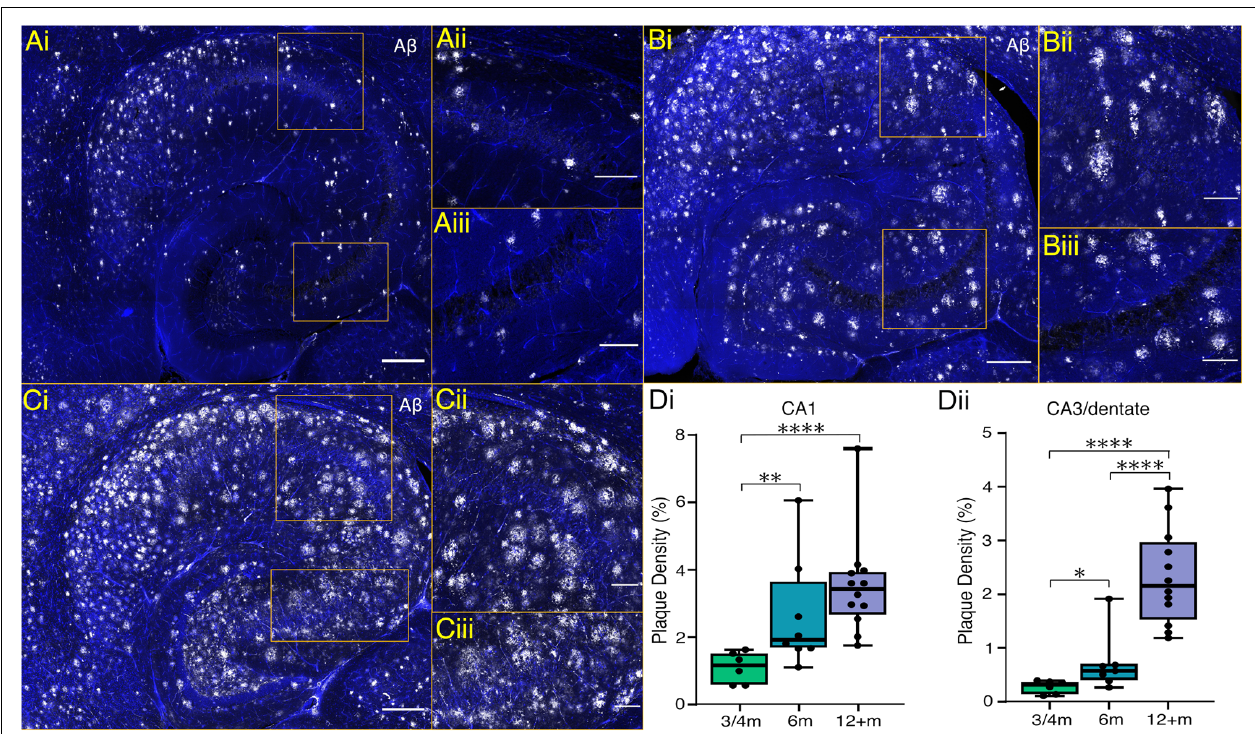
FIGURE 1 | Hippocampal plaque development in 5xFAD mice. (Ai,Bi,Ci) Representative maximum intensity projection images of ventral hippocampal slices processed with an anti-amyloid beta antibody (A β ; white) and DAPI stain (blue) from 4, 6 and 12-month-old mice, respectively (scale bar = 250 µ m). (Aii,Bii,Cii) Enlarged sections of CA1 plaque presence and (Aiii,Biii,Ciii) of CA3 (scale bar = 100 µ m). (D) The plaque densities as a percentage of measured volumes are shown from CA1 (Di) and CA3/dentate (Dii) across timepoints. Box plots show the median as a black line, boxed region as the interquartile range, and whiskers as the range with individual points representing data from one brain slice. 3–4 m: n = 6 slices from four mice (two female); 6 m: n = 8 slices from four mice (two females); 12+ m: n = 12 slices from six mice (three females). ∗ p < 0.05, ∗∗ p < 0.01, ∗∗∗∗ p < 0.0001 (one-way ANOVA with Sˇ idák correction).